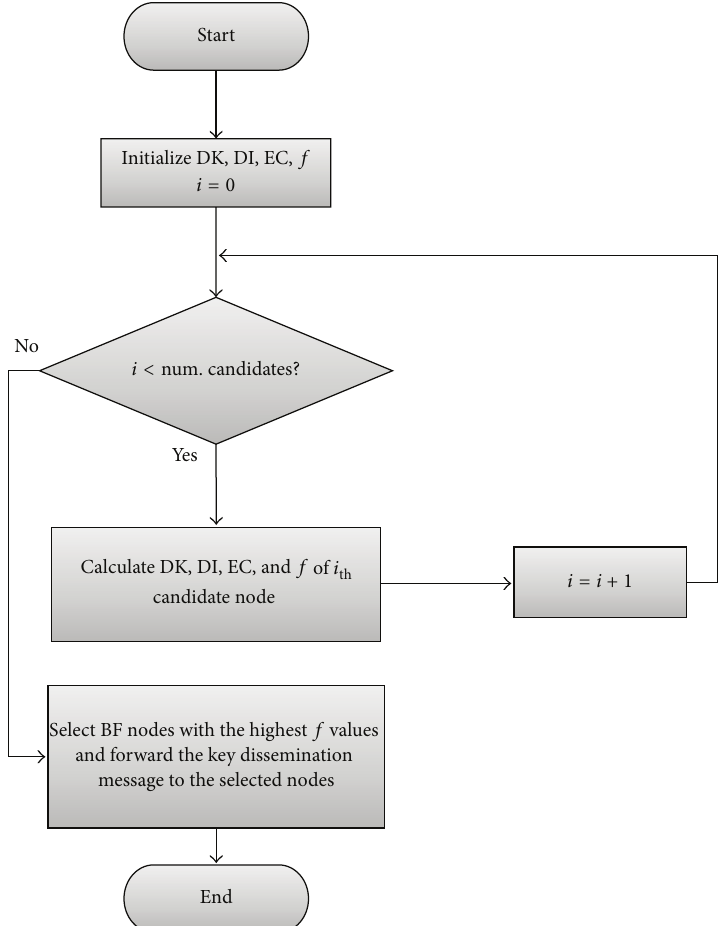
Figure 5: Internal operation of a node that receives a key dissemination